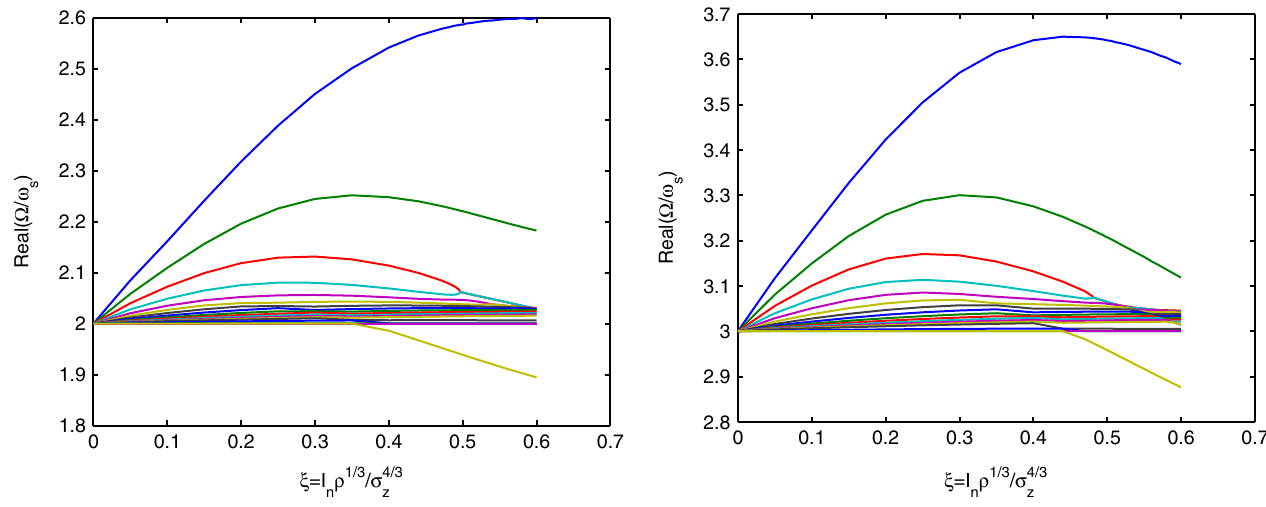
FIG. 8. Coupling of the radial modes: quadrupoles on the left and sextupoles on the right.